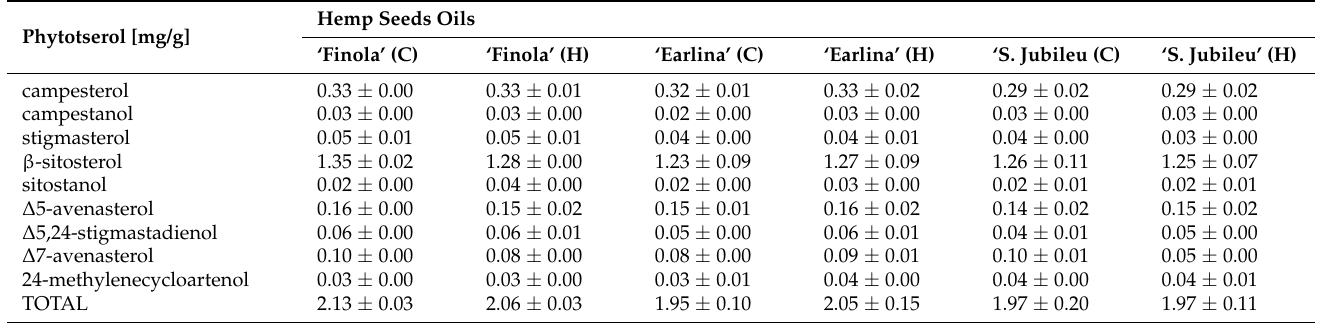
Table 5. Phytosterols content [mg/g] in oils obtained from different hemp varieties and pressing temperature.